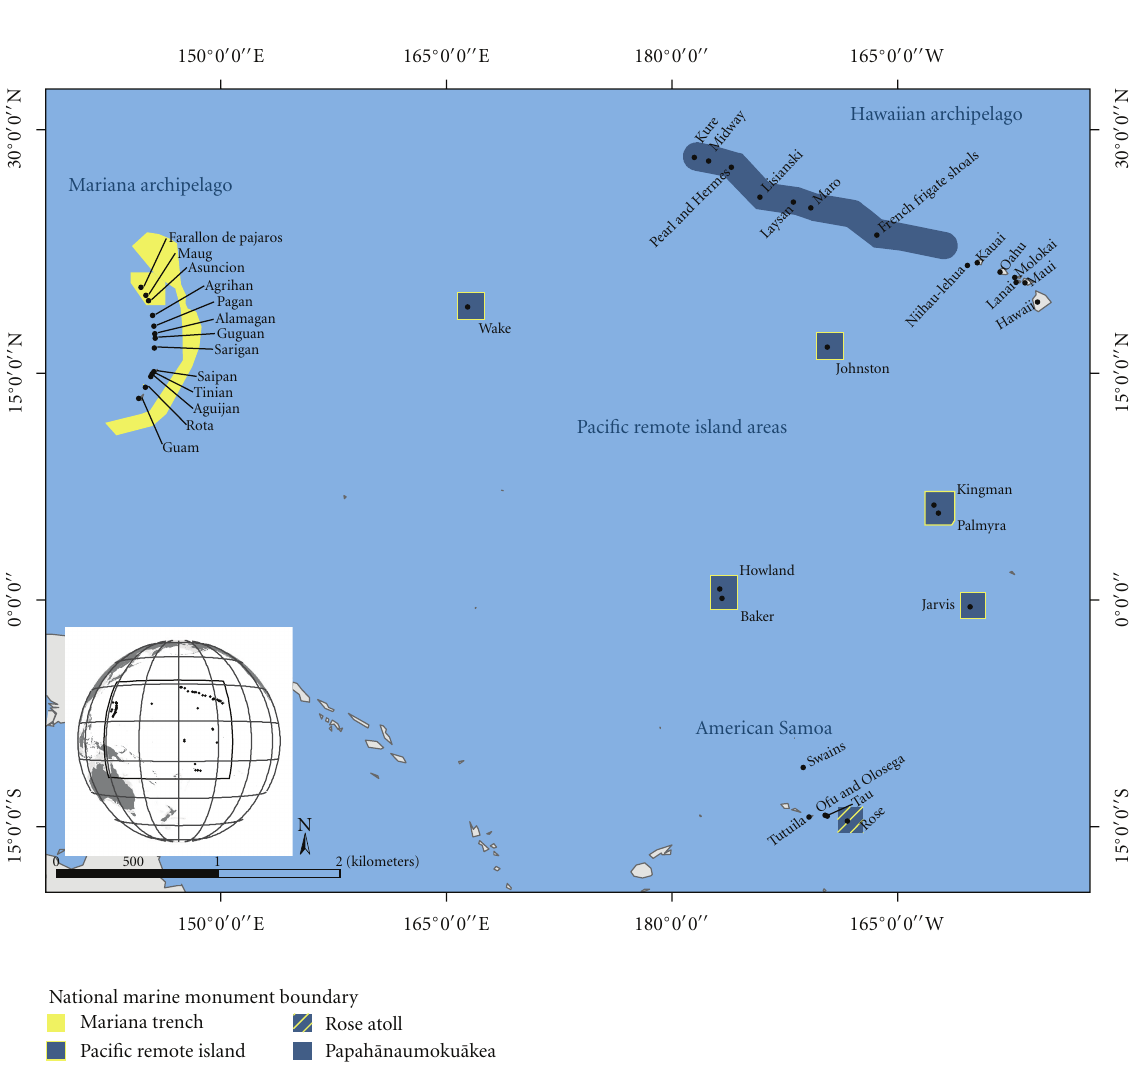
and secondary consumer biomass (by 19% and 34%,